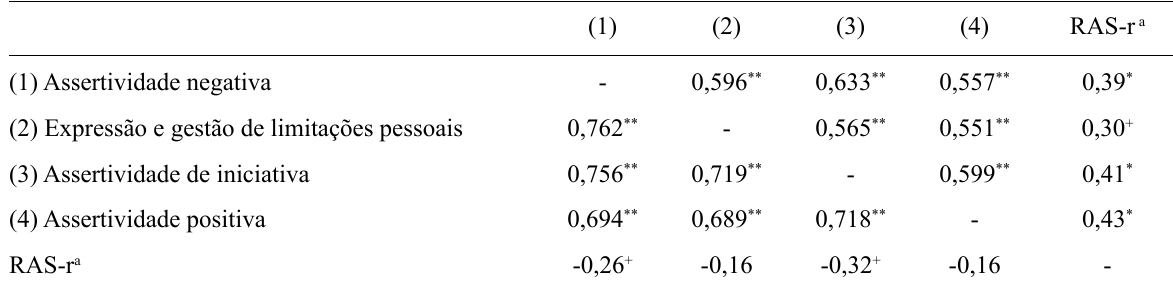
Nota . Correlações para a dimensão de frequência de comportamento são apresentadas acima da diagonal, e as correlações para a dimensão desconforto são apresentadas abaixo da diagonal. ECI-r = Escala de Comportamento Interpessoal – Versão Reduzida; RAS-r = Escala de Assertividade de Rathus – Versão